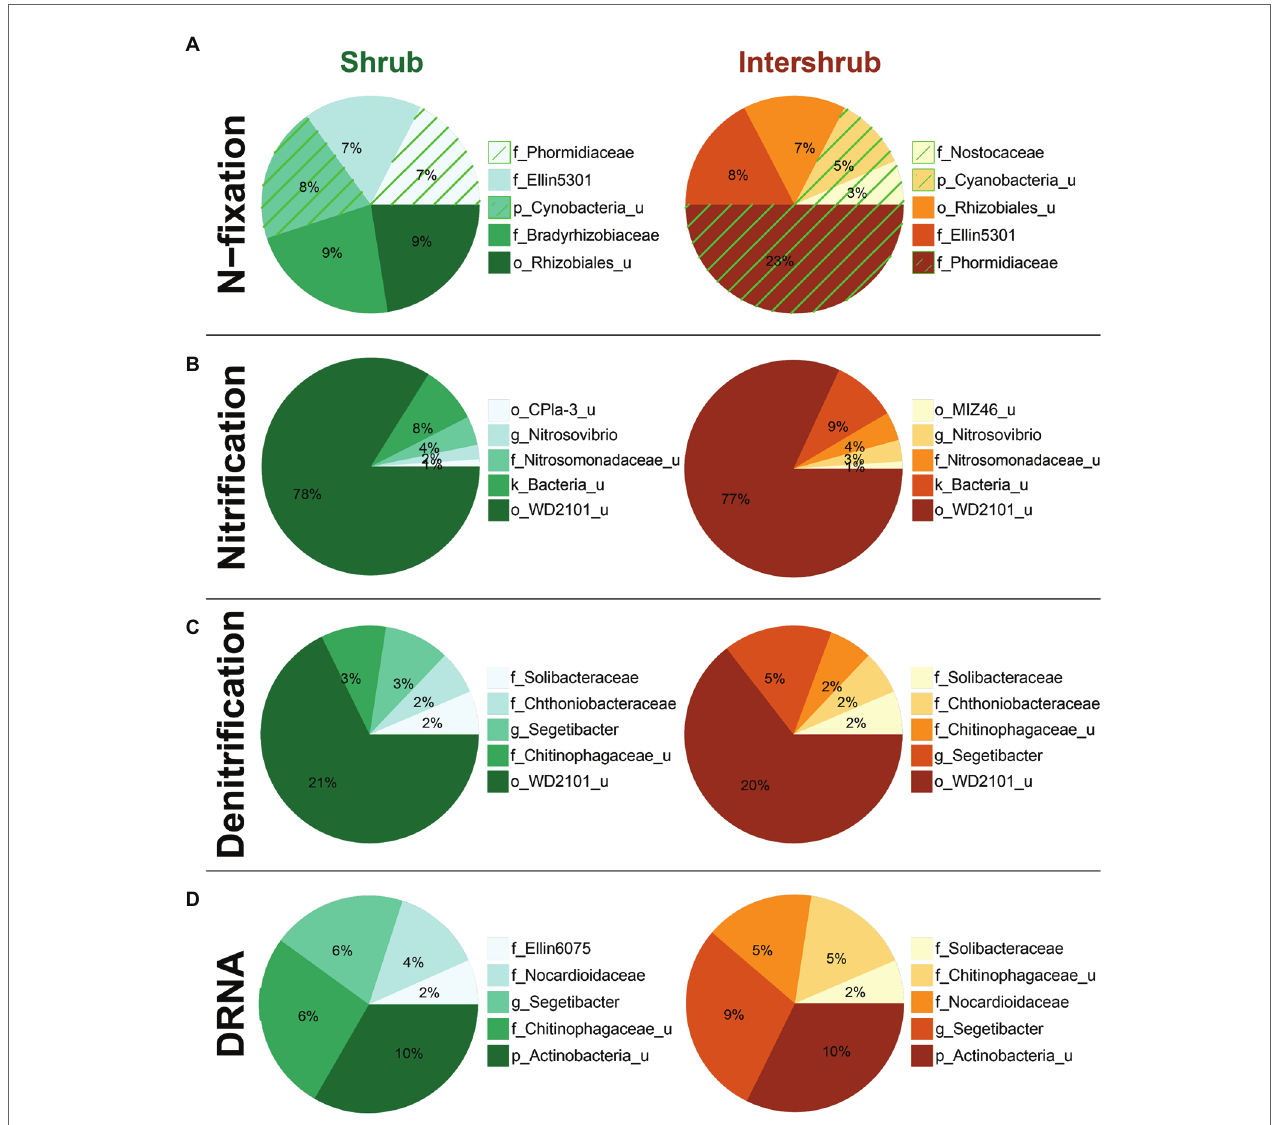
FIGURE 9 | Top five family-level functional designees across shrub/intershrub levels for (A) N-fixation (cyanobacterial taxa highlighted by green hatching), (B) nitrification, (C) denitrification, and (D) dissimilatory nitrate reduction to ammonia (DNRA). Area of each pie slice is proportional to the family’s percentage among the top five families. Numbers in the text are percentages of the families with respect to all taxa in the communities. “_u” = “unclassified”; “g_Segetibacter” = “f_ Chitinophagaceae_g_Segetibacter”; “g_Nitrosovibrio” = “f_Nitrosomonadaceae_g_Nitrosovibrio.”